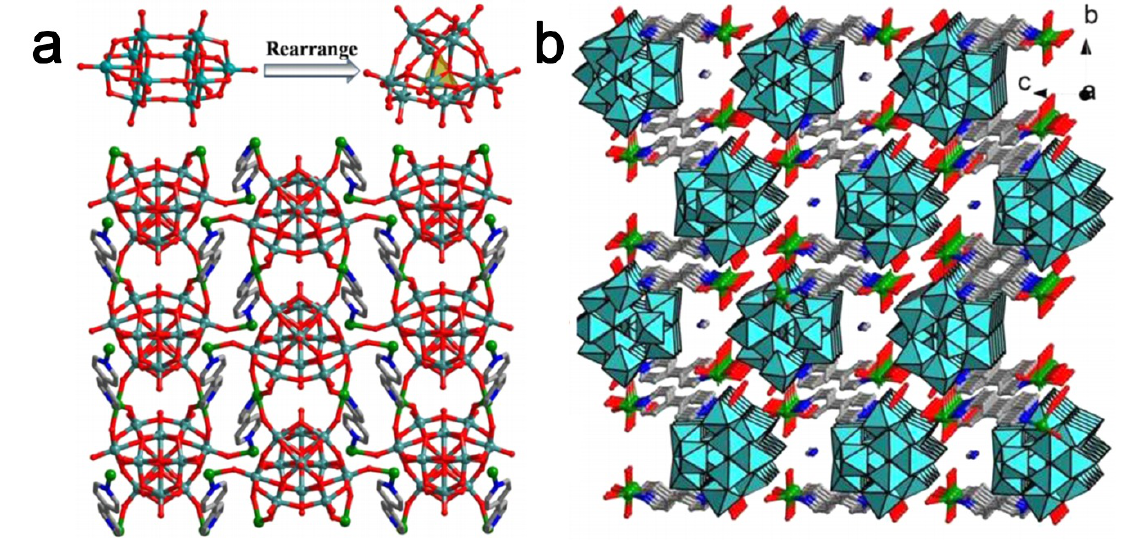
Figure 5. ( a ) The rearrangement of [W 10 O 32 ] 4 − and the 2D framework constructed